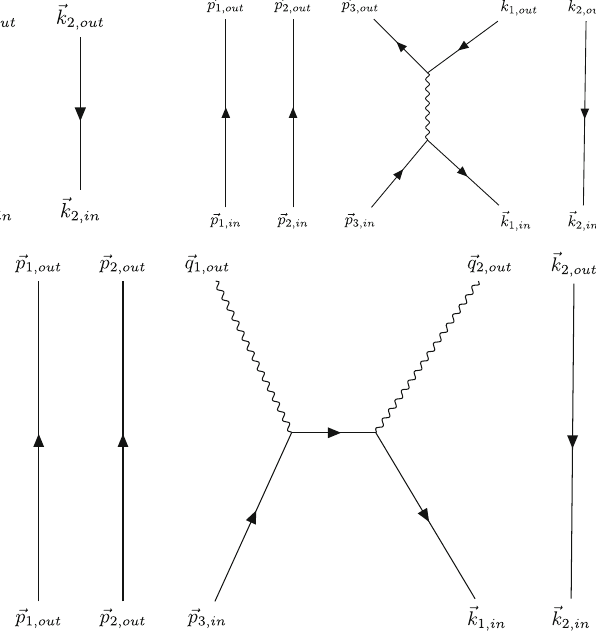
Fig. 5 A disconnected Feynman diagram contributing to i M ( 3 e − + 2 e + → 2 e − + e + + 2 γ) .Theu-channeldiagramisobtainedbyexchang- ing the outgoing photon momenta between the outgoing photon lines